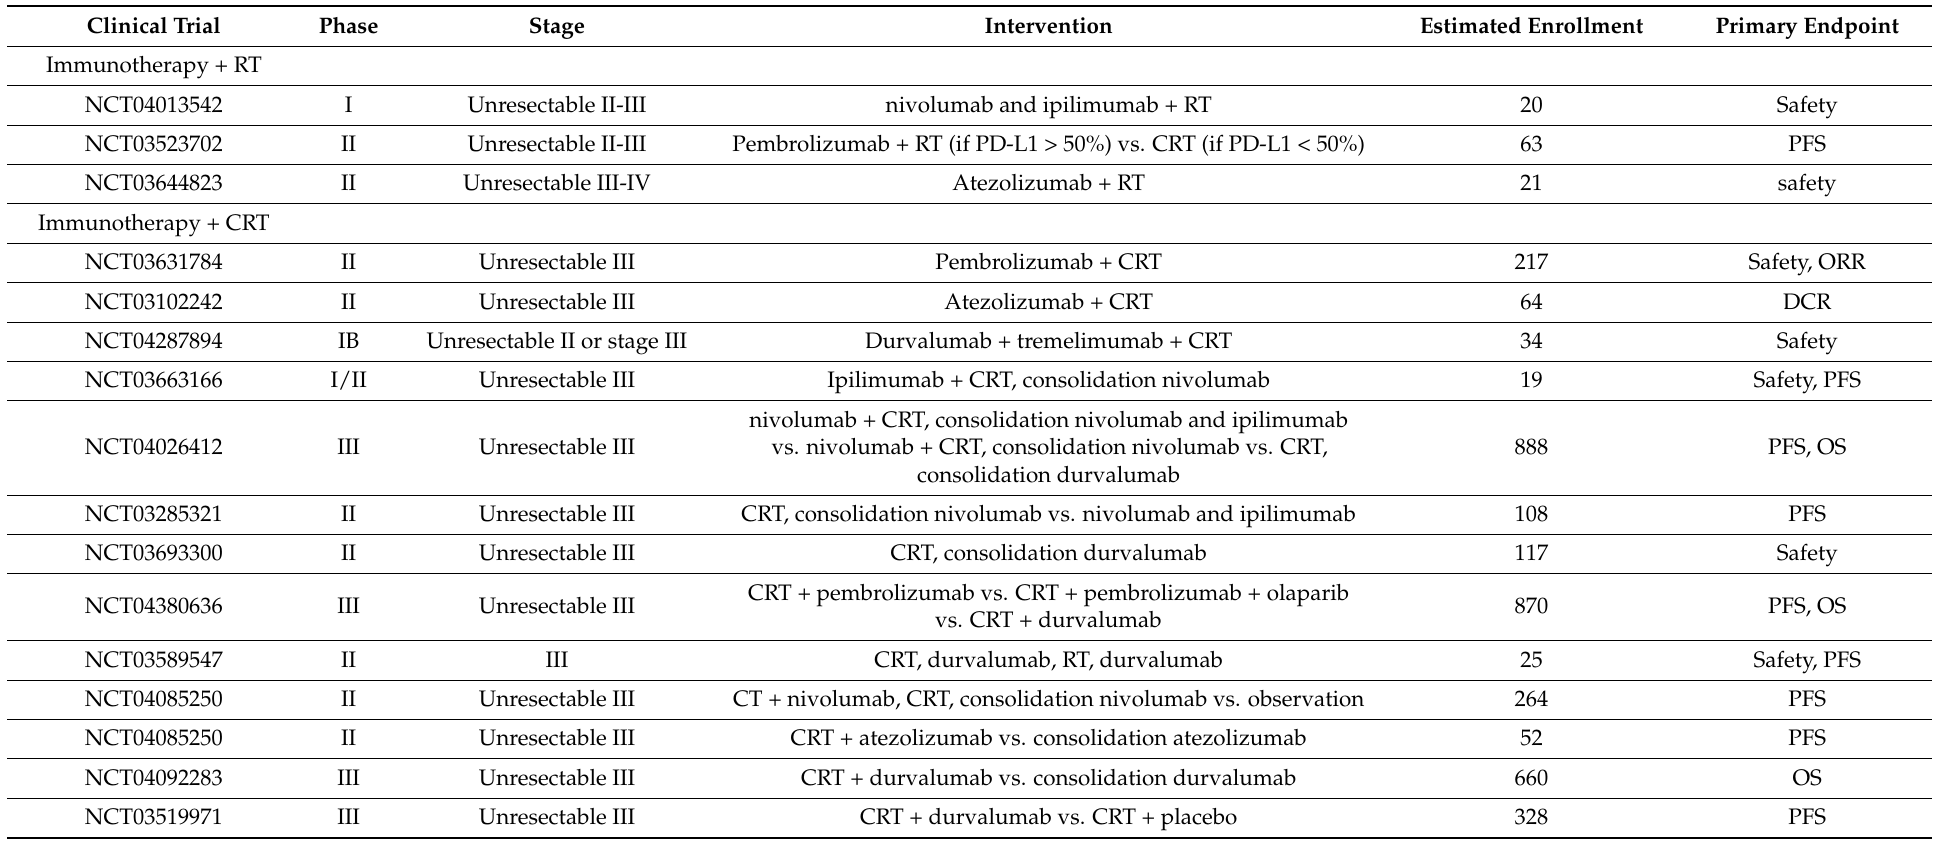
Table 2. Ongoing trails on immunotherapy in unresectable NSCLC, including stage